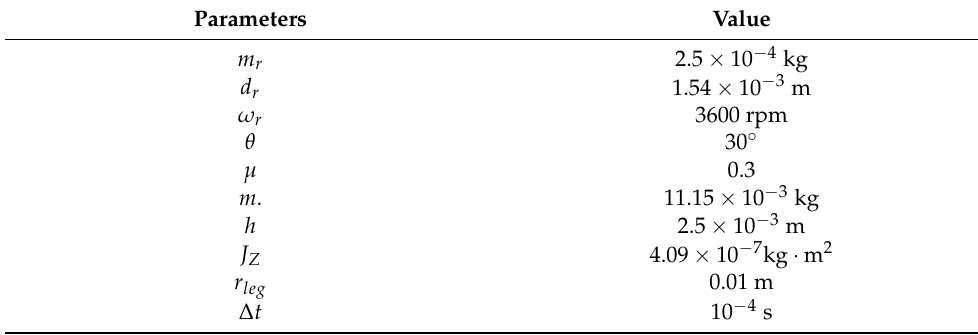
Table A2. Parameters used in the